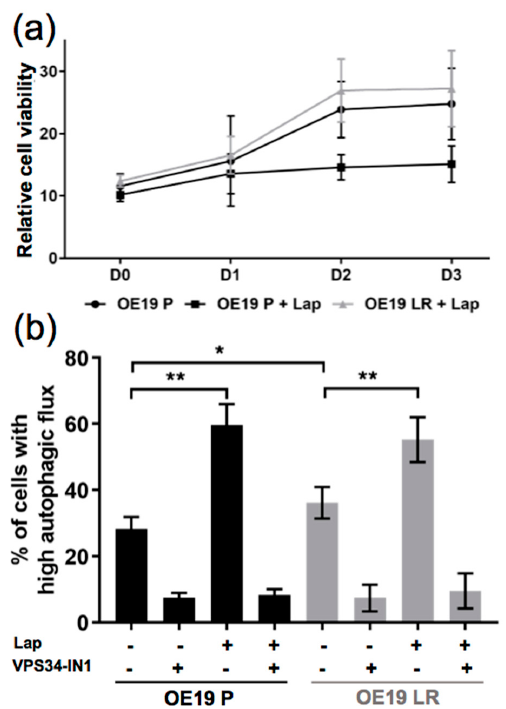
Figure 2. Comparison of the autophagic flux induction in parental (OE19 P) and Lapatinib-resistant (OE19 LR) OE19 cells. ( a ) Relative cell viability assessed by alamarBlue ® assay of OE19 P and OE19 LR cells, treated with dimethyl sulfoxide (DMSO) alone or 120nM of Lapatinib ( n = 3). ( b ) Quantification of FACS analysis comparing OE19 P and OE19 LR transduced with a mCherry-EGFP-LC3B construct (same treatment as in a). As a control, autophagy blocked conditions (addition of 5µM VPS34-IN1) were included, ( n = 4). The error bars represent SD, statistical significance was determined by Mann–Whitney U test: * p ≤ 0.05, ** p ≤ 0.01.